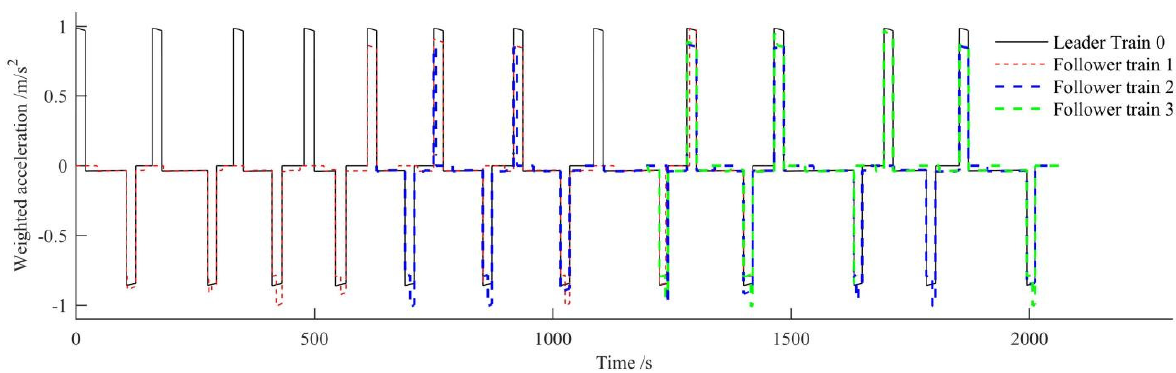
Figure 7. Change trend of the coordinated variable (weighted acceleration) of trains.